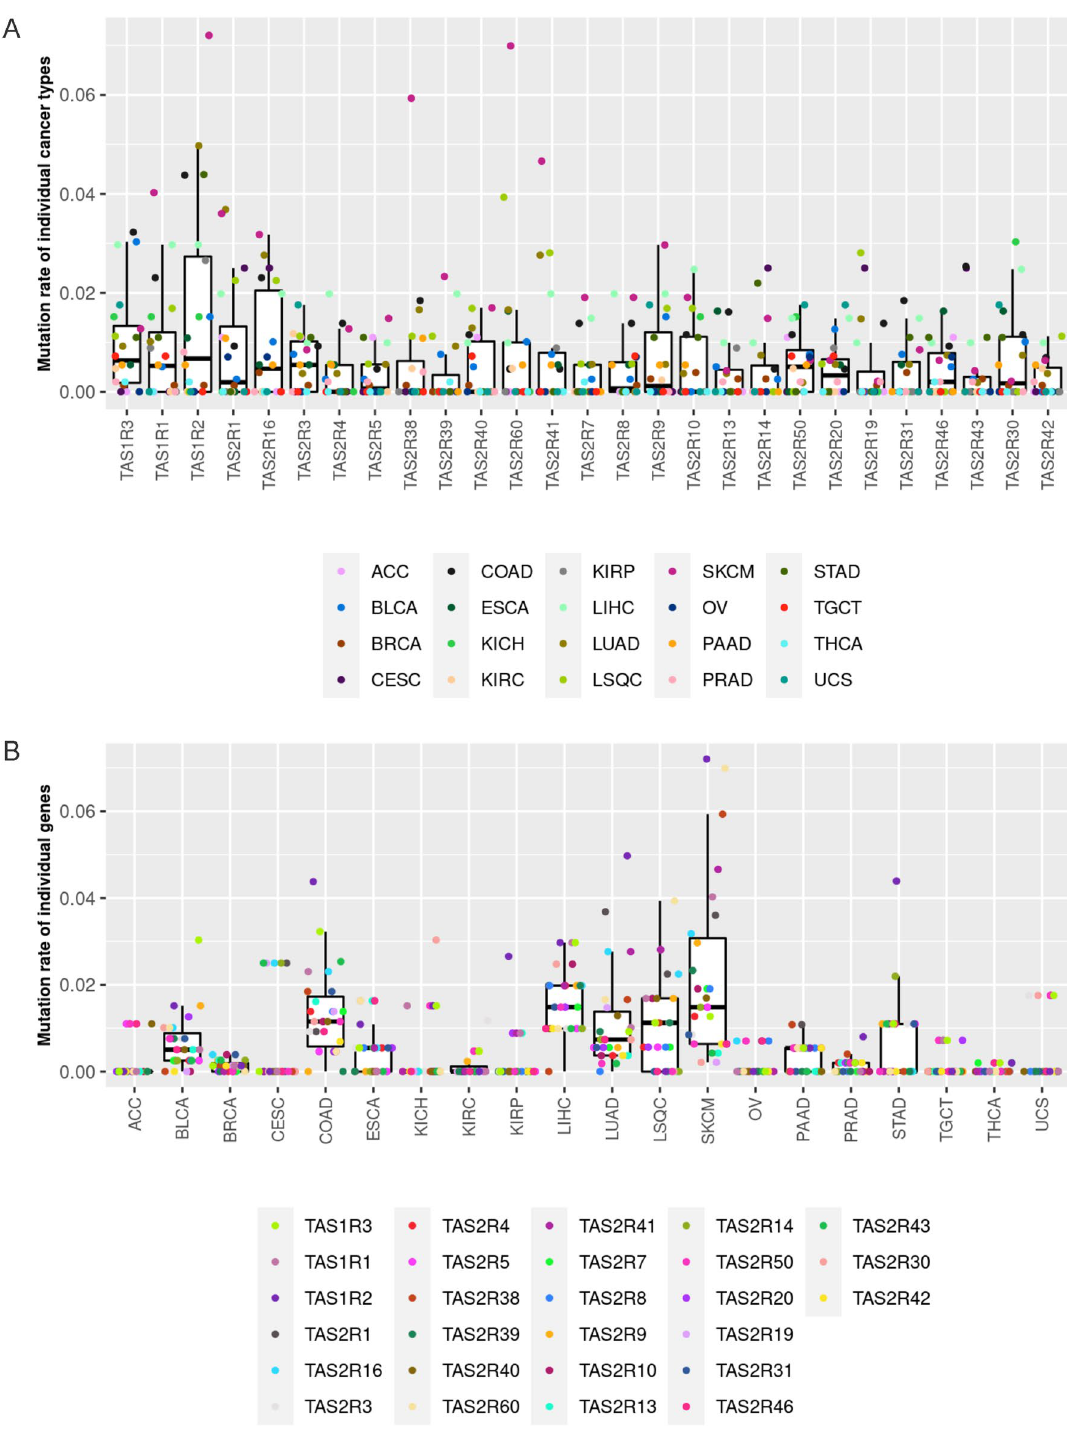
Figure 2. Somatic mutations in TAS1R and TAS2R genes in solid tumors. Analysis of nonsilent mutations in TAS1R and TAS2R genes for different TCGA solid tumor types (n = 5103 for 20 tumor types with data available), stratified by ( A ) gene and ( B ) cancer type. Dots represent the mutation rates in each tumor type or TAS1R / 2R gene. ACC Adrenocortical Cancer; BLCA bladder cancer; BRCA breast cancer; CESC Cervical Cancer; COAD colon adenocarcinoma; ESCA esophageal cancer; KICH Kidney Chromophobe; KIRC kidney clear cell carcinoma; KIRP kidney papillary cell carcinoma; LIHC liver hepatocellular carcinoma; LSQC lung squamous cell carcinoma; LUAD lung adenocarcinoma; OV ovarian cancer; PAAD pancreatic ductal adenocarcinoma; PRAD prostate adenocarcinoma; SKCM skin cutaneous melanoma; TCGA The Cancer Genome Atlas; TGCT testicular germ cell tumor, THCA thyroid cancer; UCS Uterine